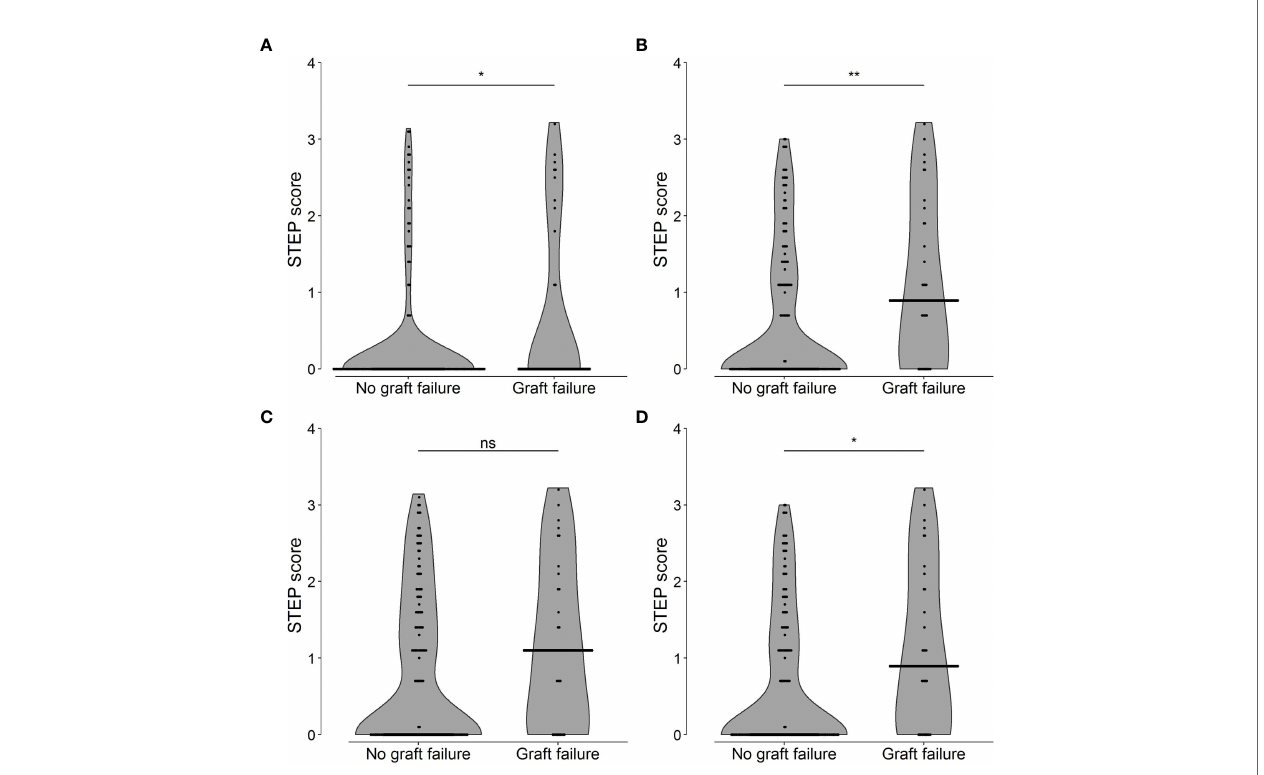
FIGURE 3 | Shared T-cell EPitopes (STEP) scores of recipients with (n=32) and without graft failure (n=158) using four different approaches (A – D) to select the positive Luminex Single Antigen (LSA) beads. (A) Inclusion of the LSA beads with a mean fl uorescence intensity (MFI)/MFI of the Lowest Ranked Antigen (LRA MFI) ratio higher than 5. p = 0.017, area under the curve (AUC) = 0.594. (B) Inclusion of the LSA bead with the highest MFI for each recipient. p = 0.010, AUC = 0.632. (C) Inclusion of the LSA beads falling in the upper 5% of the range of corrected MFI values for each recipient. p = 0.068, AUC = 0.596. (D) Inclusion of the LSA beads that fell in the upper 1% of the range of corrected MFI values for each recipient. p = 0.014, AUC = 0.627. Horizontal lines represent the median STEP scores. ROC curves with AUCs are provided in Supplementary Figure 1 . *p < 0.05, **p < 0.01 , ns, not signi fi cant.